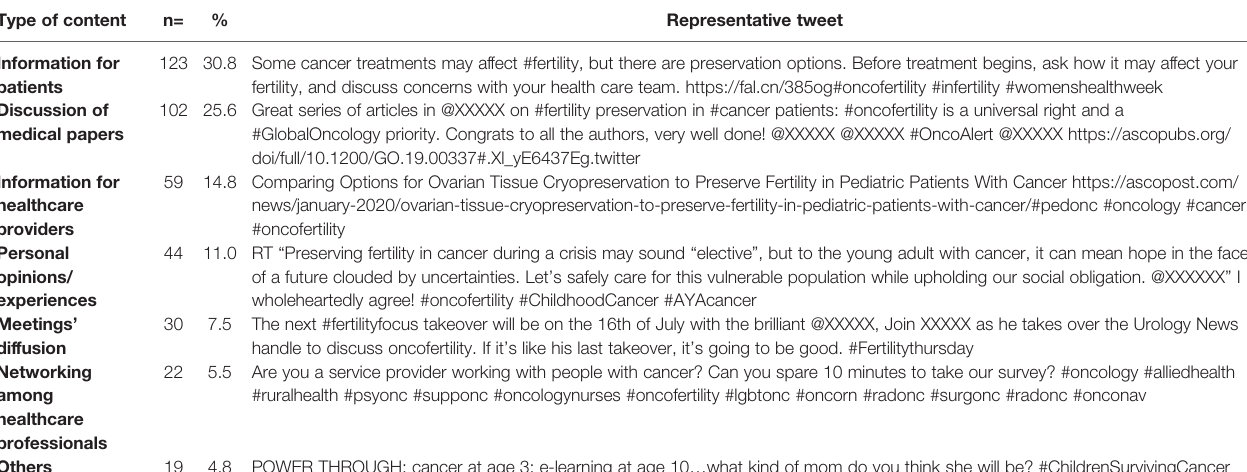
TABLE 1 | Classi fi cation of OF and FP related tweets according to their content and a representative tweet of each category. Type of content Representative tweet